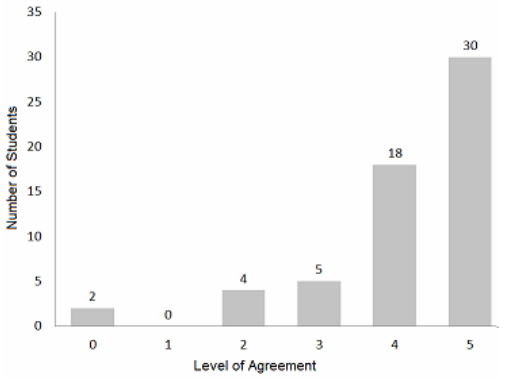
Figure 5. "This course cannot be offered in videoconferencing"